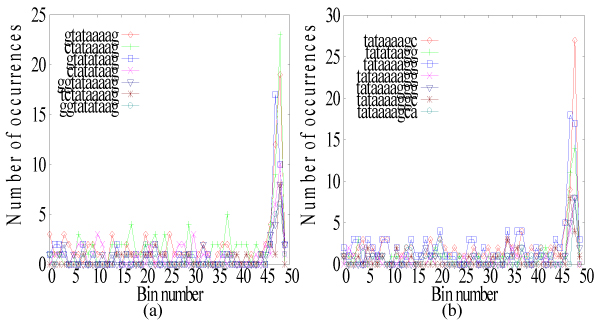
Frequency distribution of fourteen TATA Box extension sequences on S1000. Fourteen TATA extension sequences are found to show very high abundance at the location close to TSSs. Seven of them extend TATA elements from the left side as shown in Figure 4(a), and seven others from the right side as shown in Figure 4(b). Thirteen out of these fourteen sequences extend from TATAAAAG or TATATAAG. Calculation of p values for these fourteen sequences demonstrates that their high motif factors are not obtained by chance.